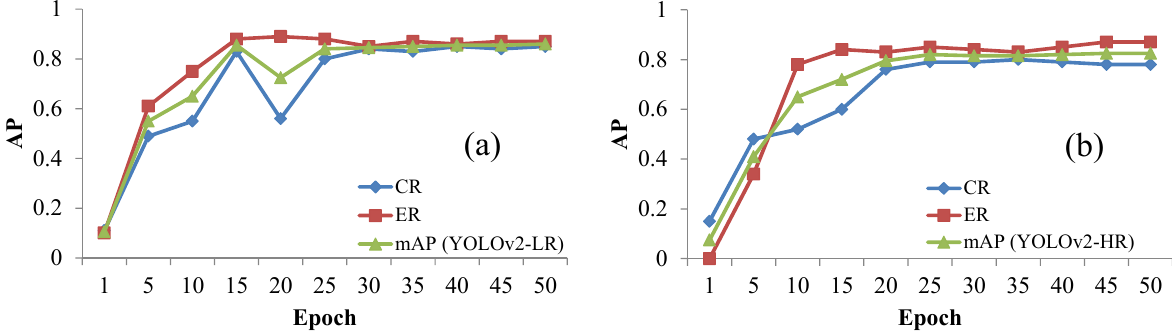
Figure 10. Detection results of the YOLOv2 with high- and low-resolution feature images: ( a ) using high-resolution feature images; ( b ) using low-resolution feature images.